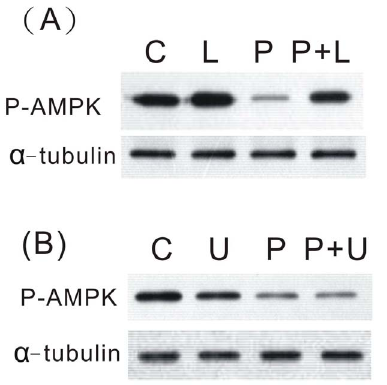
Figure 6. Effects of LY294002 (A) and U0126 (B) onPTTH- inhibited AMPK phosphorylation. C, glands incubated in control medium; P, glands incubated in medium containing PTTH only; L, glands incubated in medium containing 50 m M LY294002 only; P + L, glands incubated in medium containing both PTTH and LY294002; U, glands incubated in medium containing 10 m M U0126 only; P + U, glands incubated in medium containing both PTTH and U0126. Results shown are representative of three independent experiments.